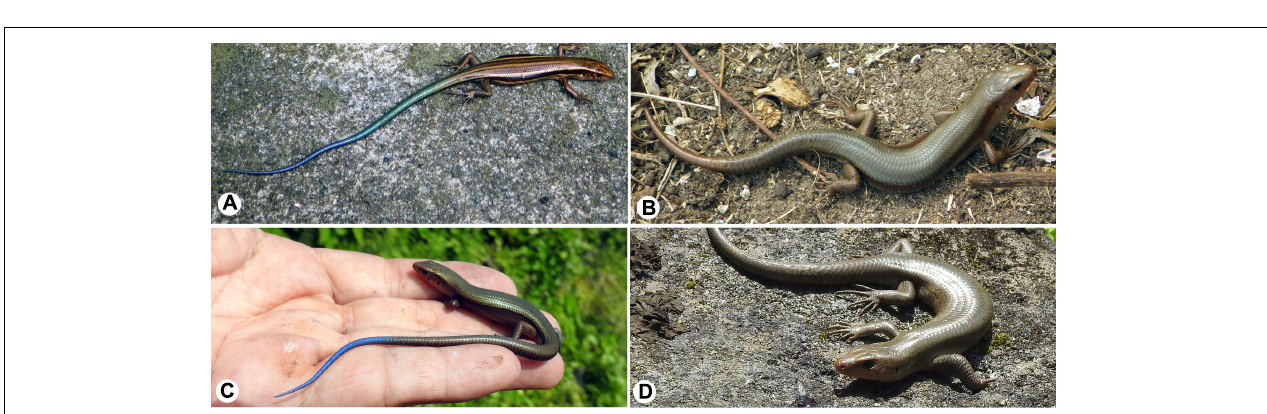
FIGURE 5 | Dorso-lateral views of Plestiodon latiscutatus juveniles and full adult males from Kozu and Hachijokojima. (A) A juvenile in Kozu island of Japan has five yellowish-white longitudinal lines in the trunk and a green tail in the anterior half that transitions to blue in the posterior region. (B) A full adult male in Kozu is almost uniformly brown. (C) A juvenile in Hachijokojima island of Japan is almost uniformly brown, except for a blue tail tip. (D) A full adult male in Hachijokojima is almost uniformly brown.